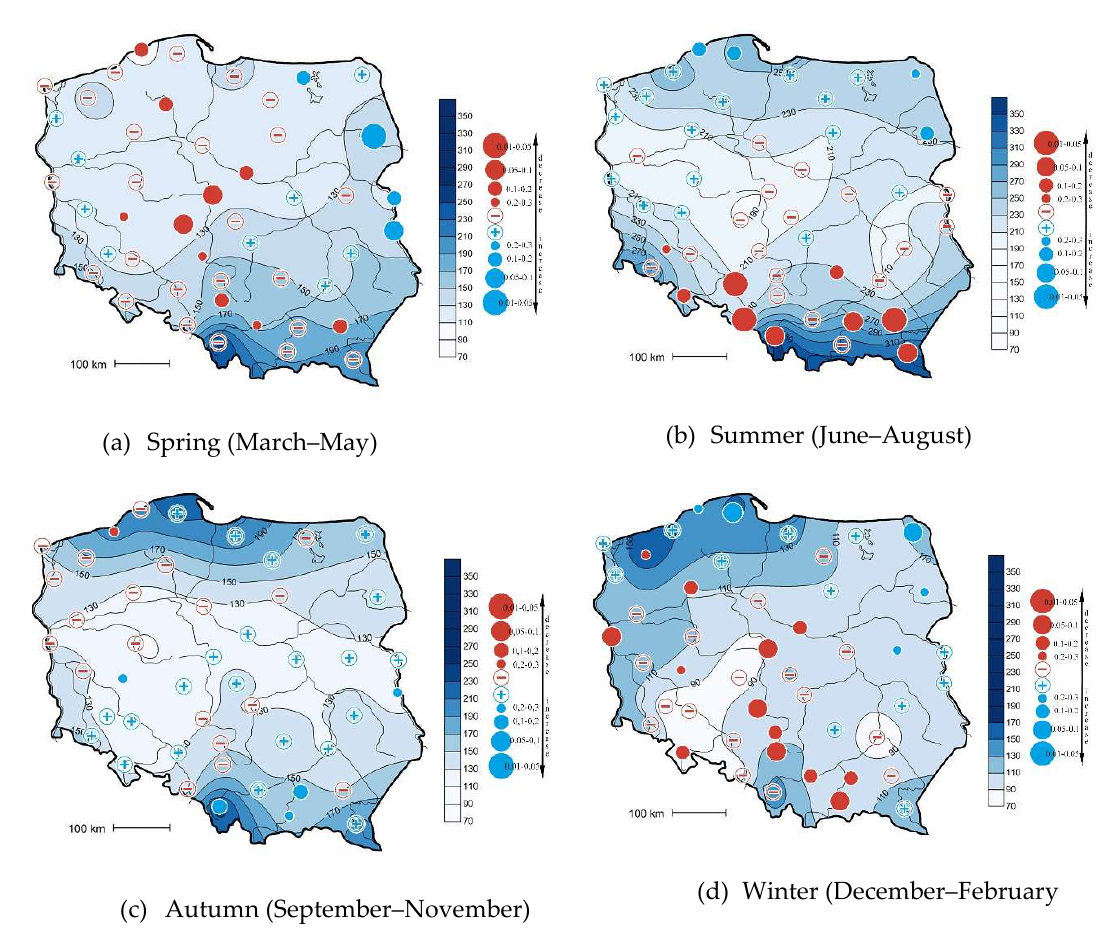
Figure 3. Spatial distribution of seasonal precipitation totals (mm) in 2001–2018 and the level of significance of changes in seasonal precipitation totals in 2001–2018 based on the Mann–Kendall test: ( a ) Spring; ( b ) Summer; ( c ) Autumn; ( d ) Winter.